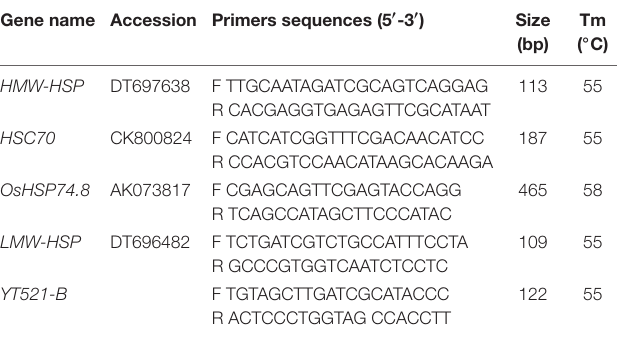
TABLE 1 | Primer sequence used for real-time quantitative PCR.